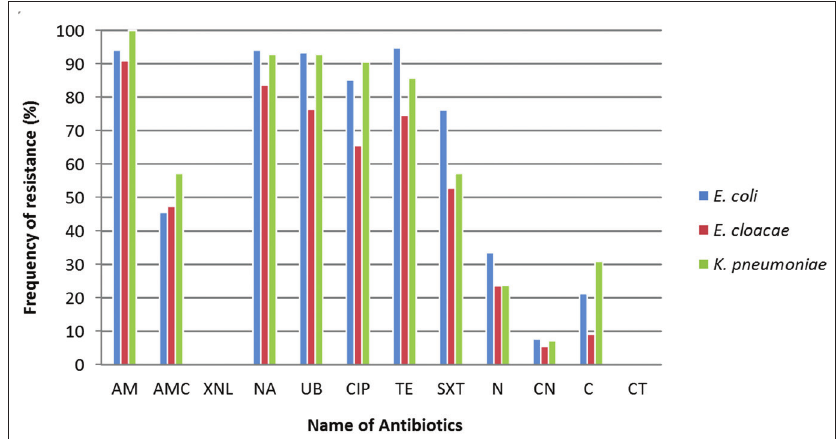
Figure-1: Antimicrobial resistance among Enterobacteriaceae. AM=Ampicillin, AMC=Amoxicillin/clavulanic acid, XNL=Ceftiofur, NA=Nalidixic acid, UB=Flumequin, CIP=Ciprofloxacin, TE=Tetracycline, SXT=Trimethoprim/ sulfamethoxazole, N=Neomycin, CN=Gentamicin, C=Chloramphenicol,